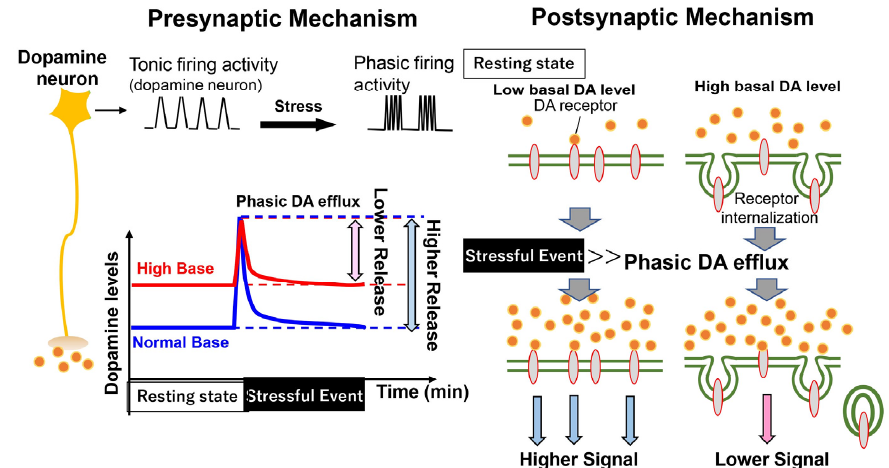
Figure 5. The effect of basal dopamine release on behavioral regulation. Releases of dopamine (DA) are regulated by two independent modes: tonic and phasic activities of dopamine neurons. In the resting state (a baseline condition), tonic activity contributes to maintaining basal dopamine levels in the targets. Stressful events cause a phasic activity to trigger dopamine release and acutely increase dopamine levels. In contrast, a higher basal dopamine level at the resting state decreases the dynamic range of phasic dopamine efflux, attenuating the dopamine-dependent behavioral responses (Presynaptic Mechanism). Alternatively, the increased basal dopamine level causes the internalization of dopamine receptors in the targets and downregulates the receptor signaling. Even if the event-related phasic dopamine efflux occurs, the responses of the postsynaptic dopamine receptors are attenuated (Postsynaptic Mechanism).